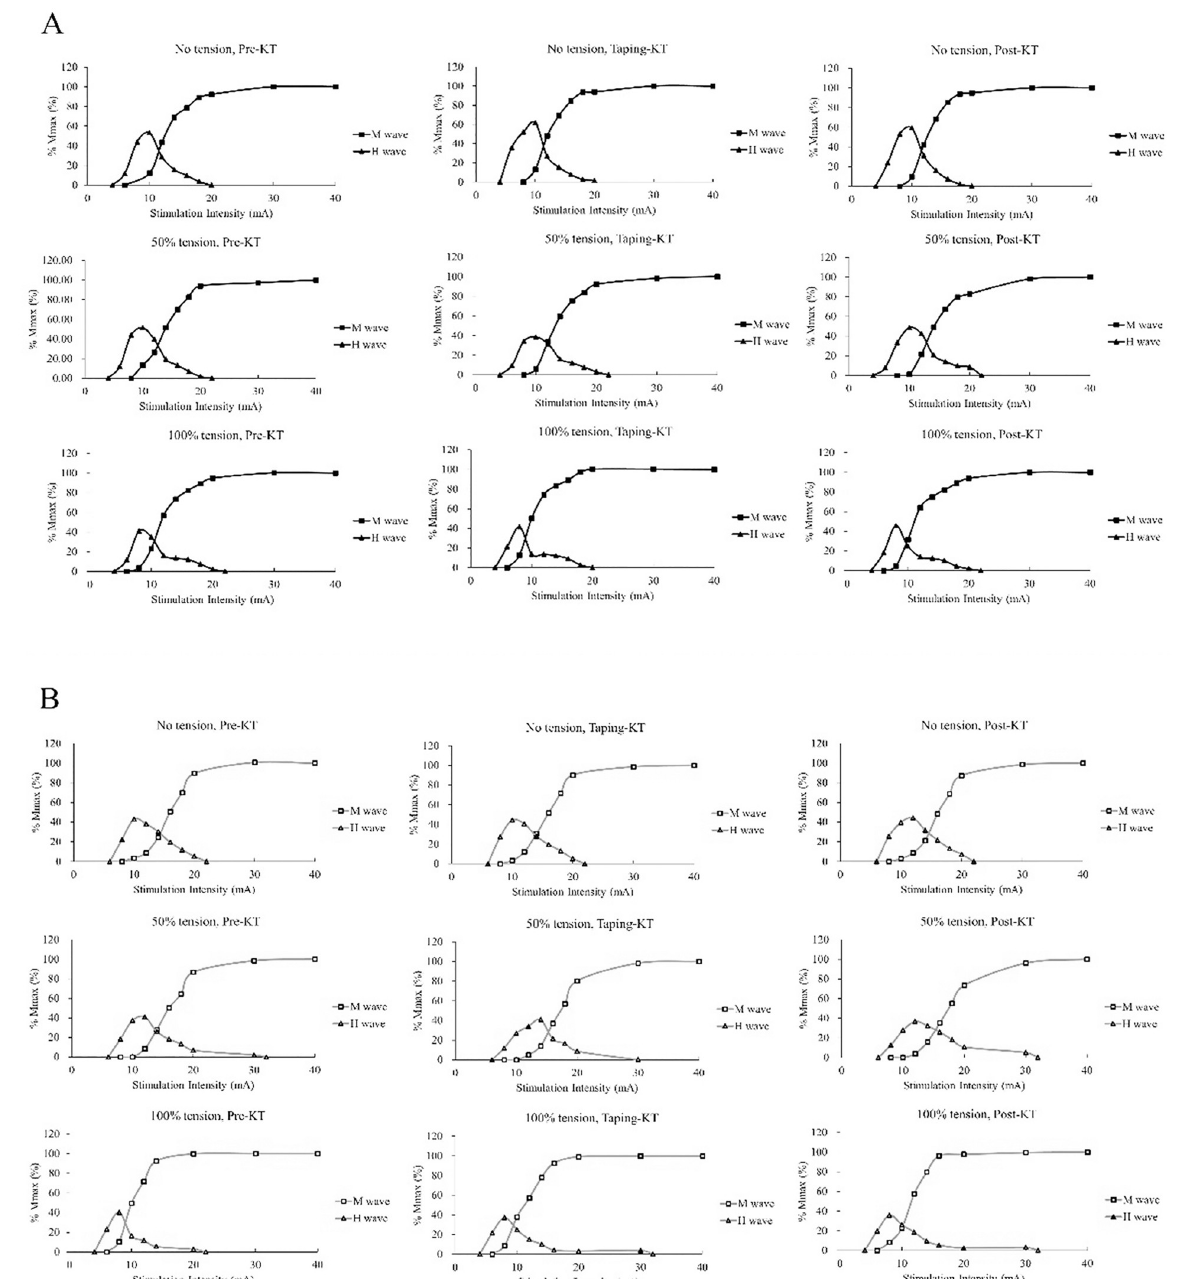
Fig 3. The example of a participant’s H-wave and M-wave recruitment curve before (Pre), during (Mid), and after (Post) different KT intensities at the lying (A) and standing (B)